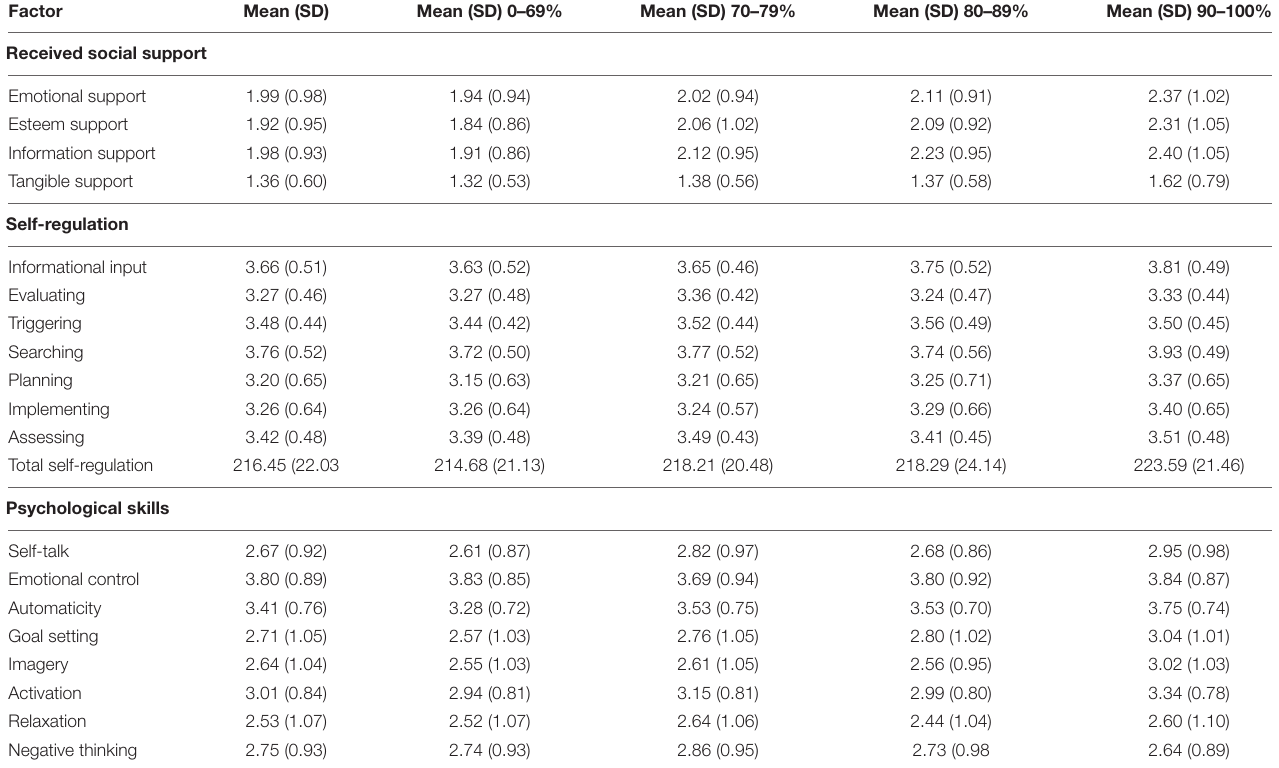
TABLE 1 | Means and standard deviation (SD) for received social support, self-regulation, and psychological skills for the sample as a whole and for the different skill categories.